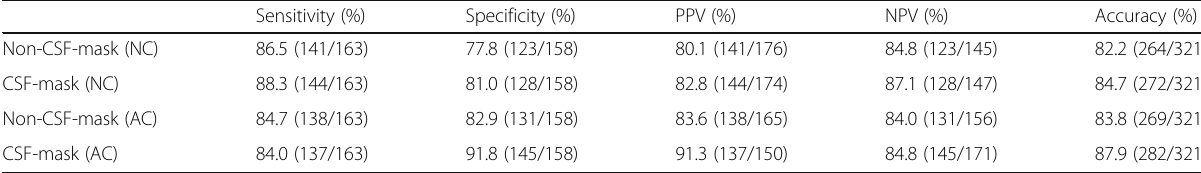
Table 2 Sensitivity, specificity, PPV, NPV, and accuracy of the SBRs with and without the CSF-mask algorithm Sensitivity (%)